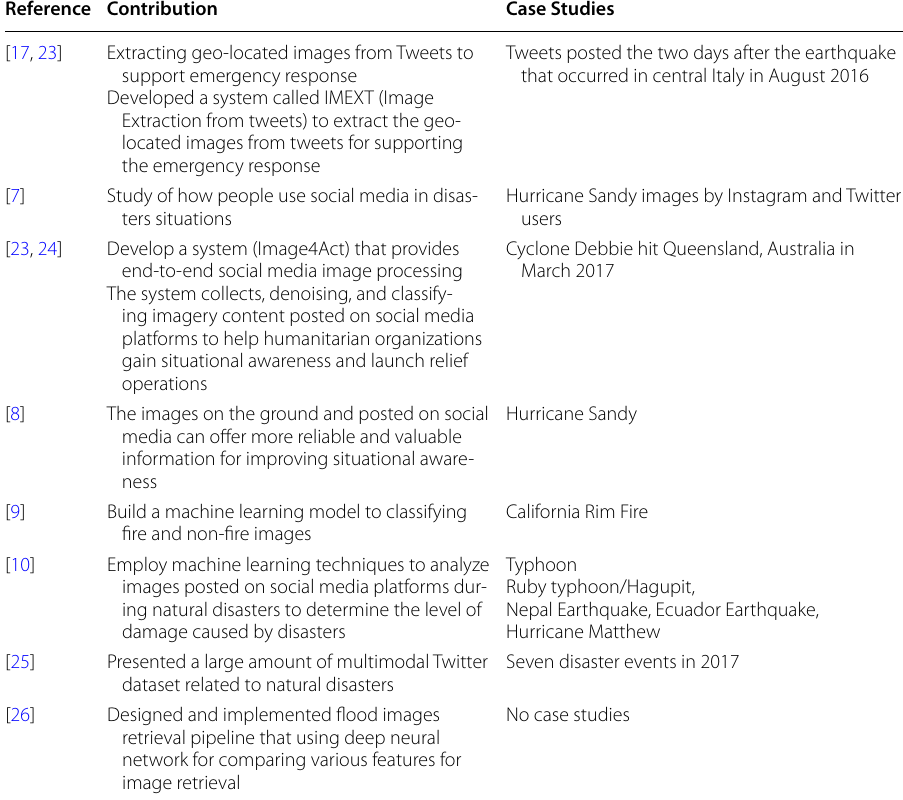
Table 2 Analysis of related work for disaster image classification models and algorithms Reference